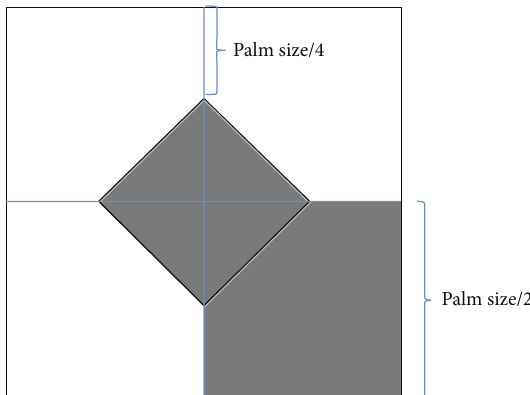
Figure 13: The grey color indicates the “Nonfingertip appearing area,” and this area is derived from the right hand.